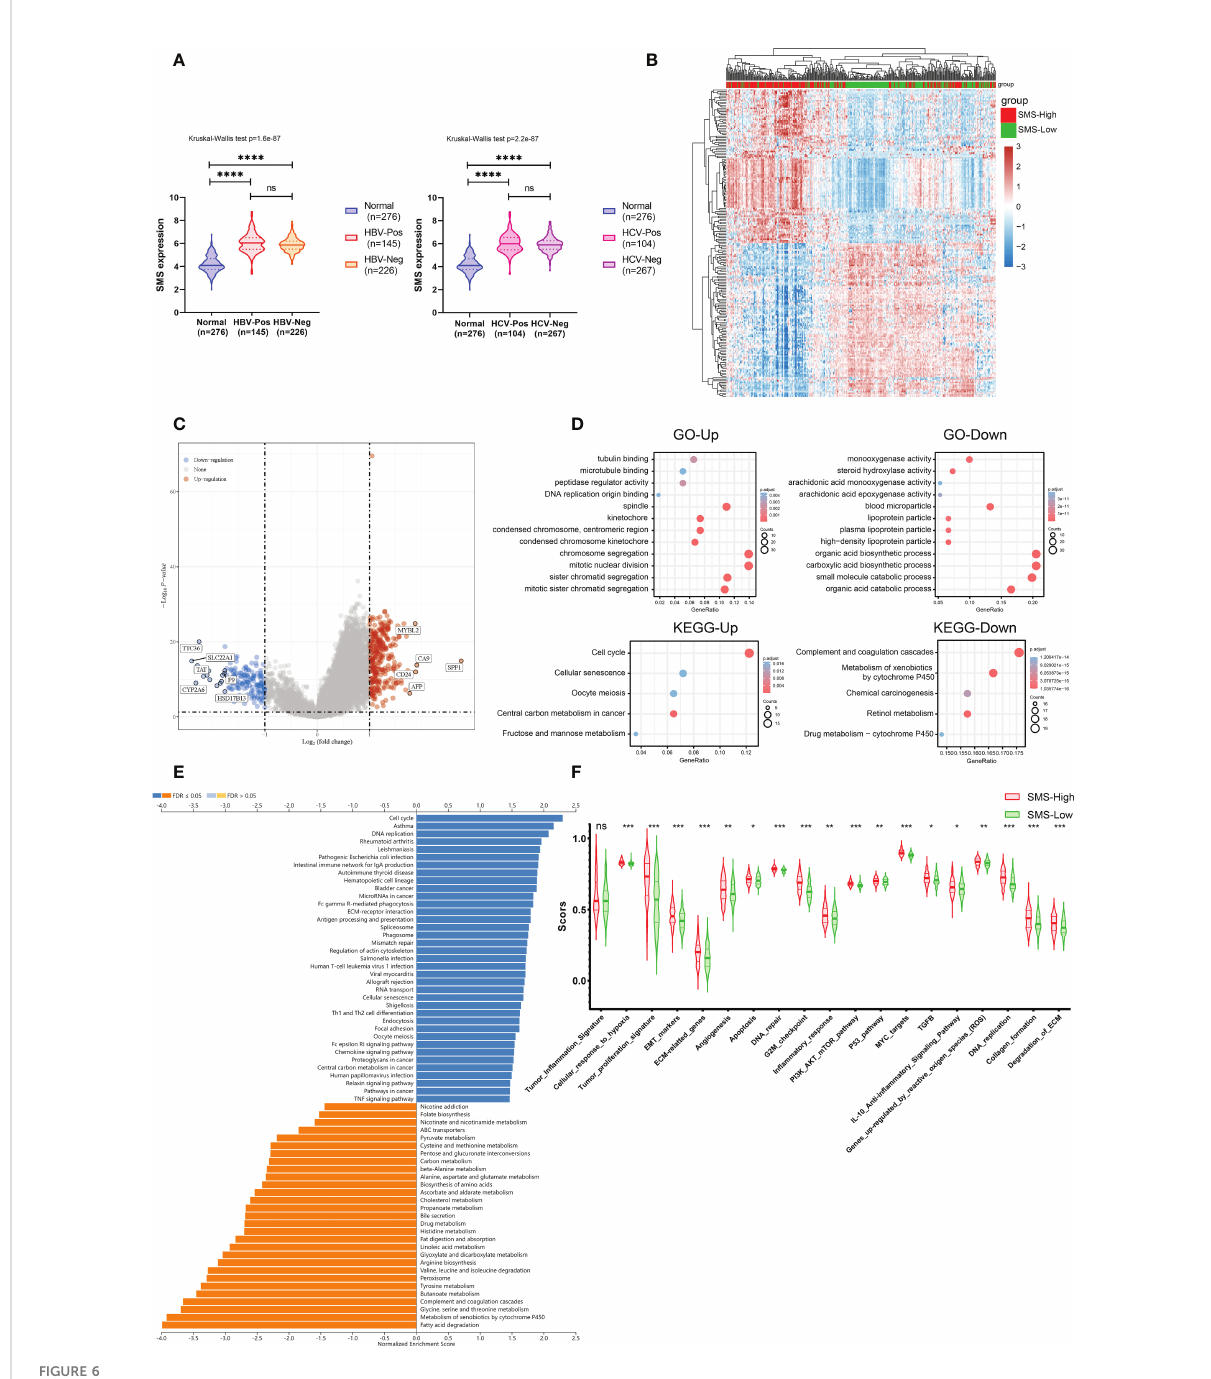
FIGURE 6 Functional analysis of DEGs in HCC patients with distinct SMS levels. (A) SMS expression in HCC patients with or without Hepatitis virus infection and in normal liver tissues. (Left, HBV; Right, HCV) (B) The heatmap of differential gene expression between the indicated groups. (C) Volcano plots of the gene expression pro fi le data. (D) Up- and down-regulated genes were analyzed for GO terms and KEGG pathway. (E) GSEA of the high and low SMS expression clusters. (F) ssGSEA scores of 19 functional pathways related to cancer between the indicated groups. *p<0.05, **p<0.01, ***p<0.001, ****p < 0.0001 vs. indicated control, ns, no signi fi